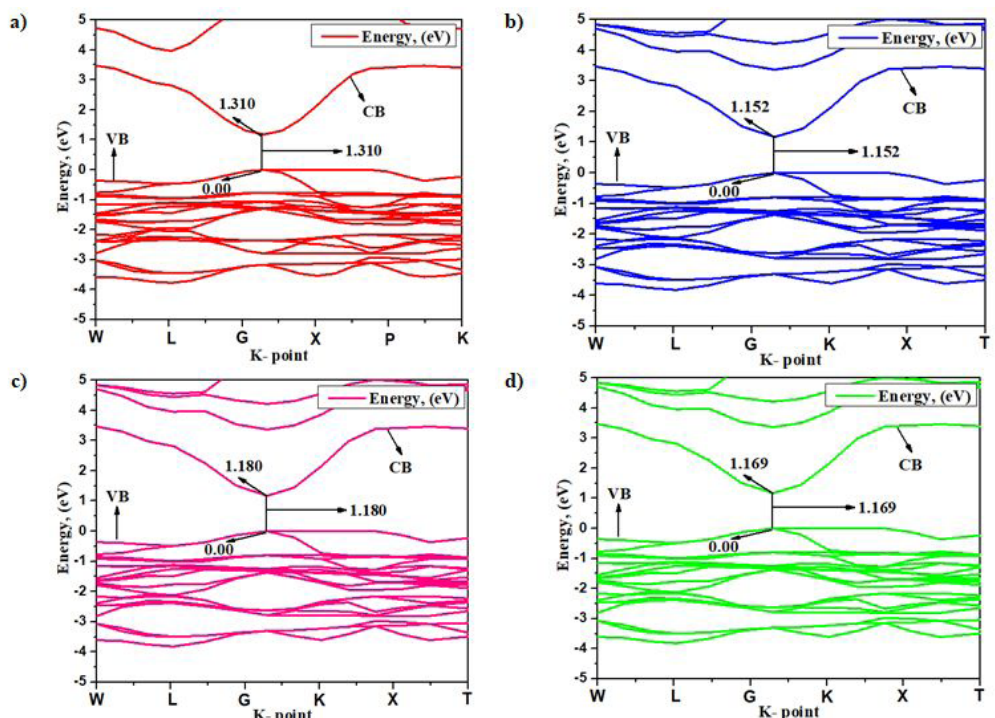
Figure 1. a) Optimized structure of Cs Optimized structure of Rb